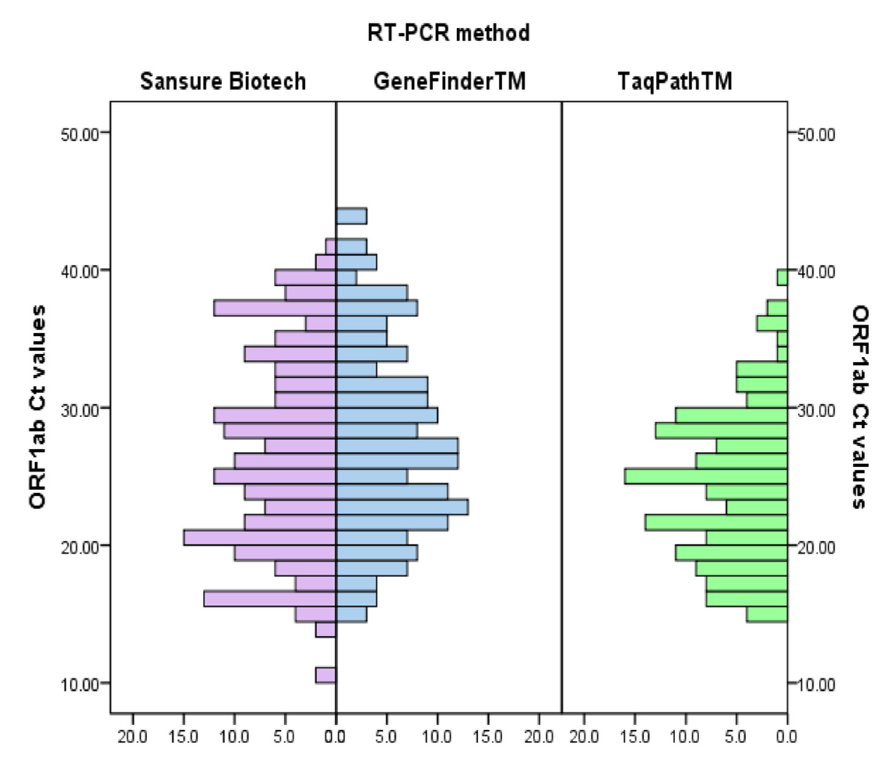
Figure 1. Distribution of Ct values that refer to amplification of ORF1ab gene according to the applied